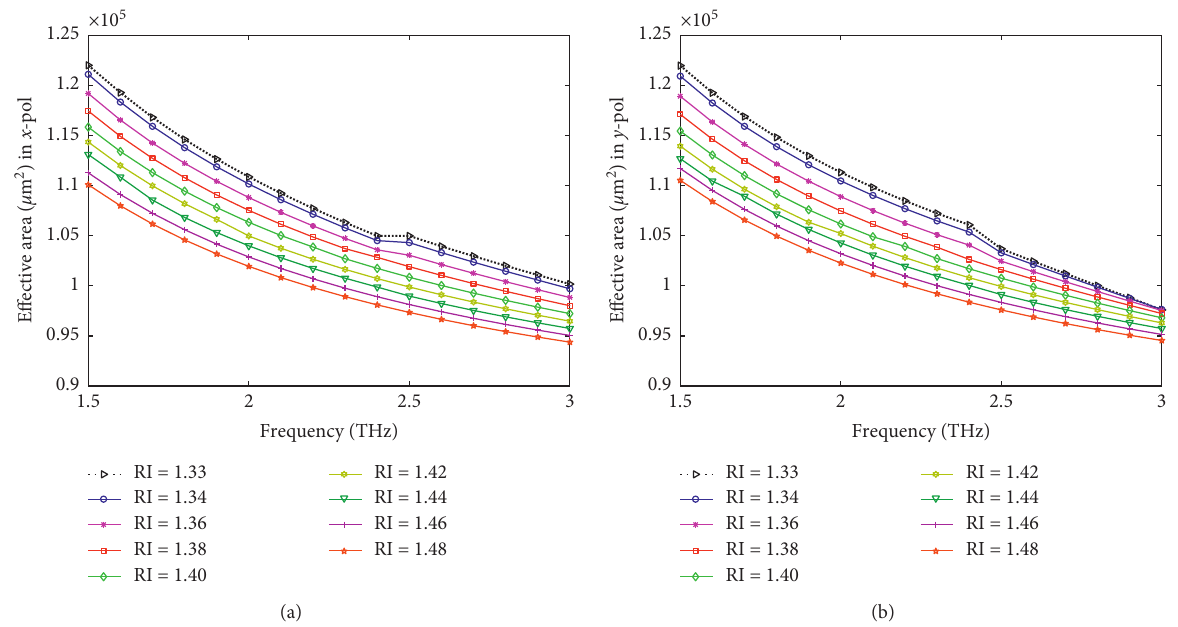
Figure 15: Comparison of the EAs in the THz band for different analytes with different RI. (a) x -PoM and (b) y -PoM.